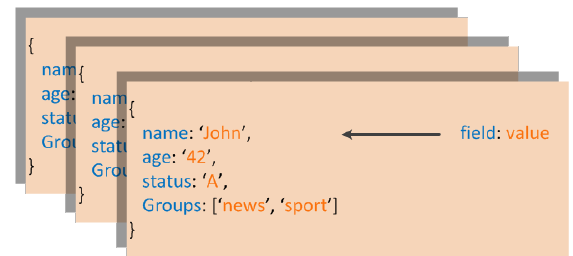
Figure 4. MongoDB logica organization of data.